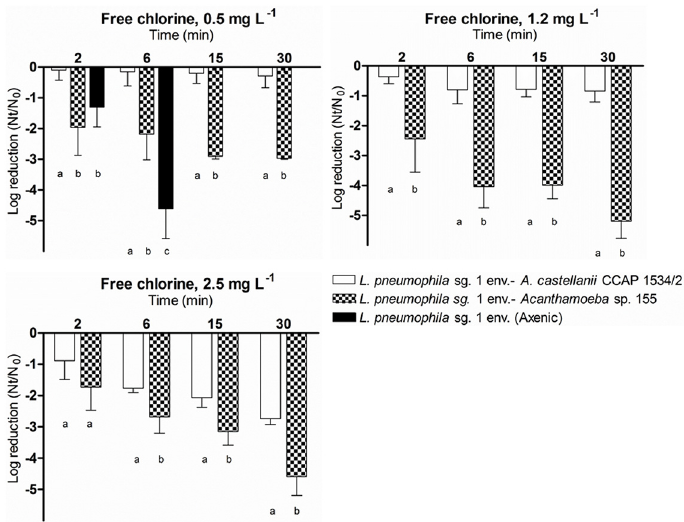
Fig 6. Effect of free chlorine, on the inactivation of L . pneumophila sg. 1 env. associated to two Acanthamoeba strains, A . castellanii CCAP 1534/2 and Acanthamoeba sp. 155 strains. Bacterial inactivation was determined using viable counts on BCYE medium. Data are presented as means ± SD (columns and error bars; n = 3). Statistical differences between means within each time point were represented assigning different letters to the bar plot. The same letter was assigned to bars with no significant differences between them. Statistical analyses were performed by ANOVA and pairwise Fisher ’ s LSD test ( p < 0.05).